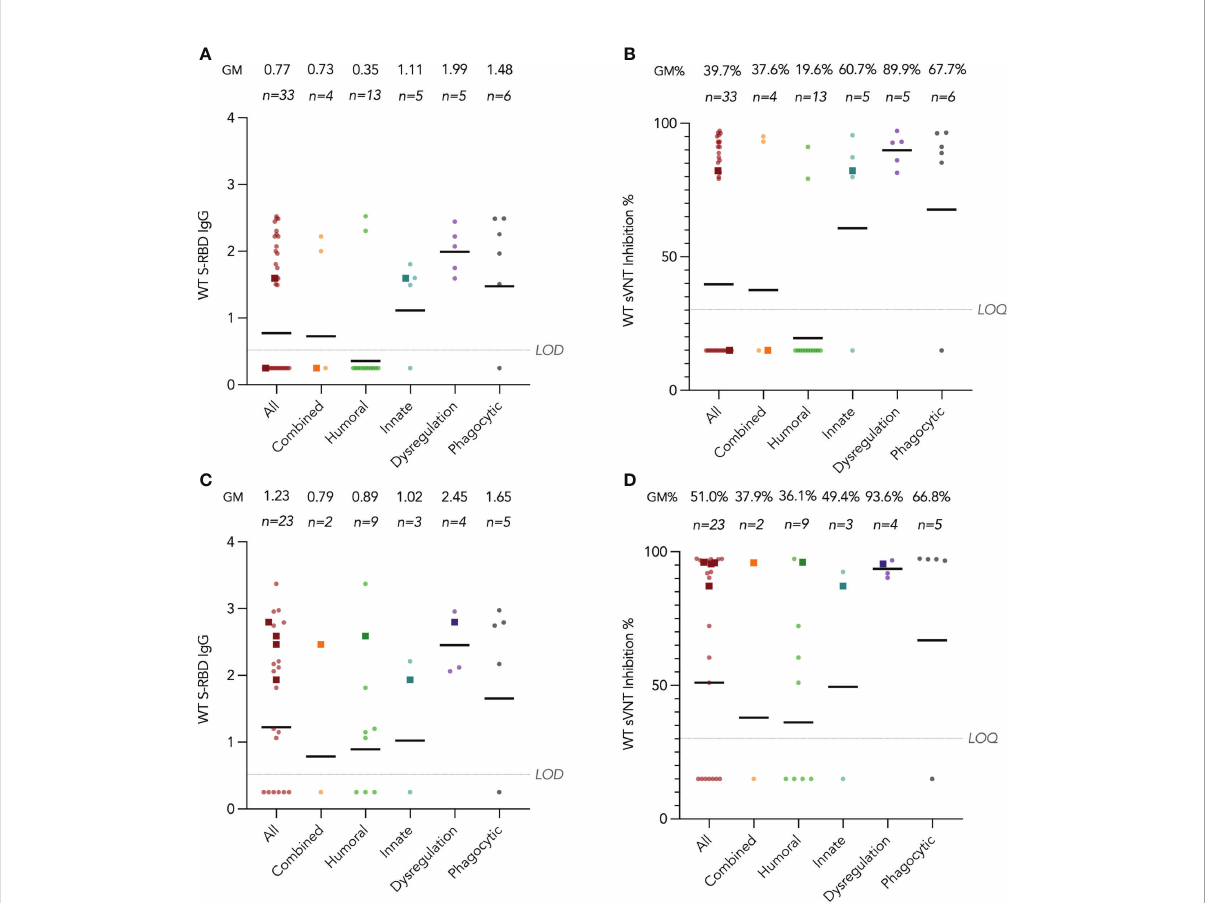
FIGURE 2 Wild-type (WT) Spike-receptor binding domain (S-RBD) IgG and surrogate virus neutralization test (sVNT) results after COVID-19 vaccination by disease category. (A) and (B) show S-RBD IgG and sVNT results respectively in fi ve disease categories (combined, humoral, innate, dysregulation and phagocytic) after 2 doses, while C and D show S-RBD and sVNT results after 3 doses. Geometric means (GM) are shown with centre lines and stated above each column. Limits of detection and quanti fi cation (LOD and LOQ) were drawn as grey lines, and the y-axis shows the range of the assays. Number of analyzed available samples (n) are also stated above each column. A and B included 2 patients (one each in combined and innate) who received fi rst 2 doses intradermally and their datapoints were shown as darkened squares. (C) and (D) also included 4 patients (1 each in combined, humoral, innate and dysregulation) who received their third dose intradermally and their datapoints were also shown as darkened squares.